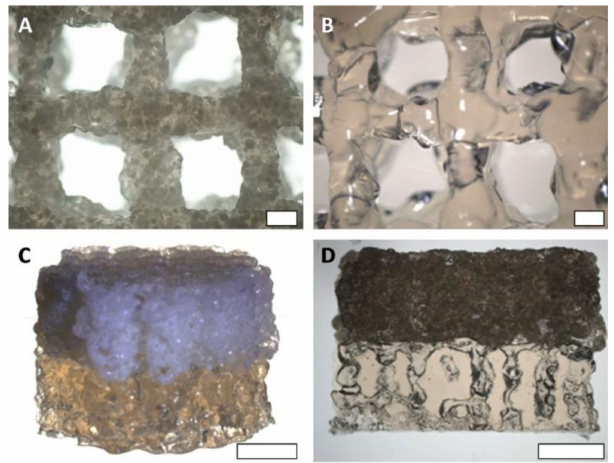
Figure 8. Bi-layered GelMA-GG cylindrical osteochondral graft model (16 mm diameter, 1 cm height). ( A ) MC-laden layer top view, ( B ) GelMA-GG layer top view, ( C ) perspective, ( D ) cross-section. Scale bars are ( A , B ) 400 µ m and ( C , D ) 4 mm (Reproduced with permission from Reference [111], copyright 2014, IOP Science Publishing).